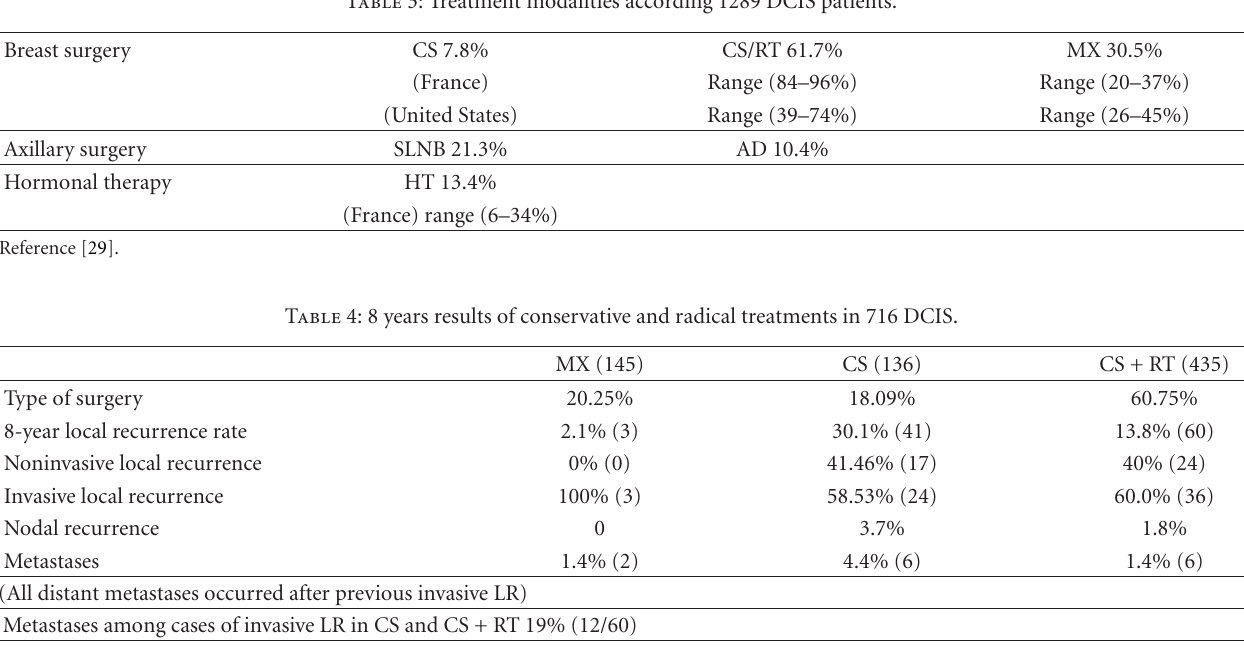
Table 3: Treatment modalities according 1289 DCIS patients.